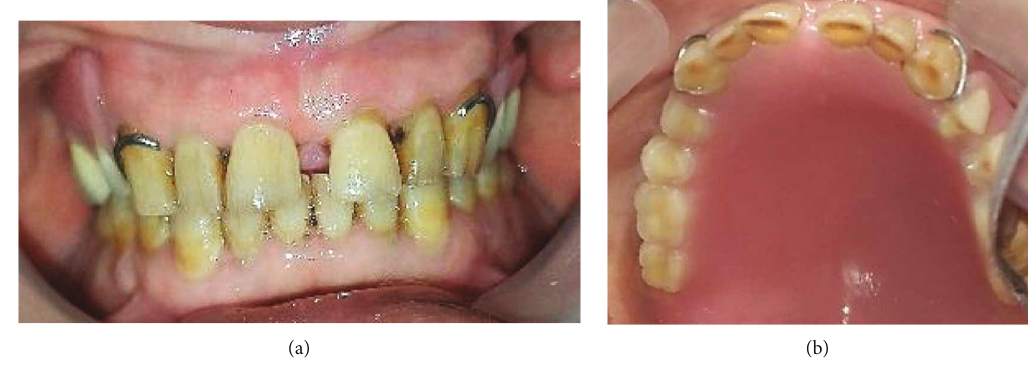
Figure 11: Mouth insertion: (a) frontal view; (b) occlusal